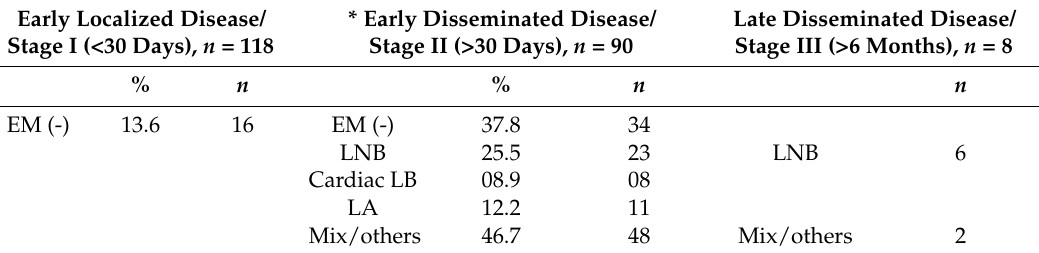
Table 2. Distribution of clinical borreliosis manifestations in patients from Latvia. Early Localized